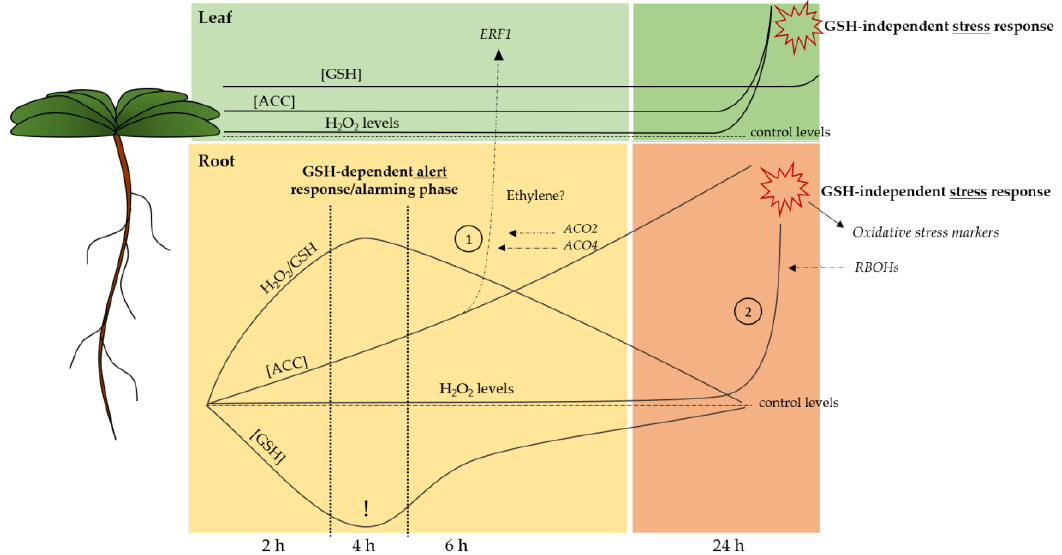
Figure 5. Proposed spatiotemporal timing for the identified pressure points that precede acclimation under cadmium (Cd) stress. (1) Roots serve as command centre, possibly via ethylene, to engage the leaves in an optimal response later on. (2) Stress persistence: responses are intensified via the increased expression of RBOHs and elevation of H 2 O 2 . This stress response is independent of glutathione (GSH). Full lines indicate Cd-induced responses and dashed lines represent control levels. Dashed arrows refer to gene expression that possibly contributes to the Cd-induced response. Full arrows refer to Cd-induced changes in gene expression as a result of the Cd-induced response. ACC: 1-aminocyclopropane-1- carboxylic acid; H 2 O 2 : hydrogen peroxide; ERF1: ethylene responsive transcription factor 1: ACO : ACC oxidase; RBOH: respiratory burst oxidase homologue.